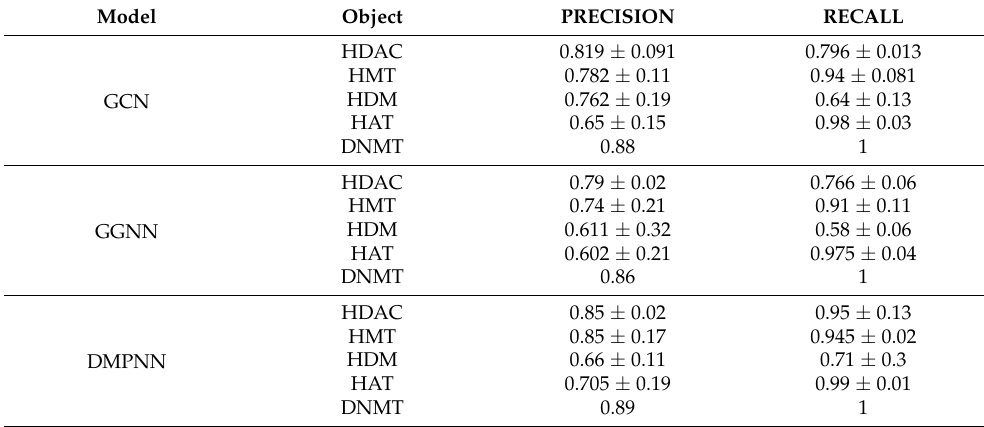
Table 2. Single-target performance comparison of three GNNs. The supervised learning algorithm was XGBoost. Results of Precision and Recall for these 24 single-target binary